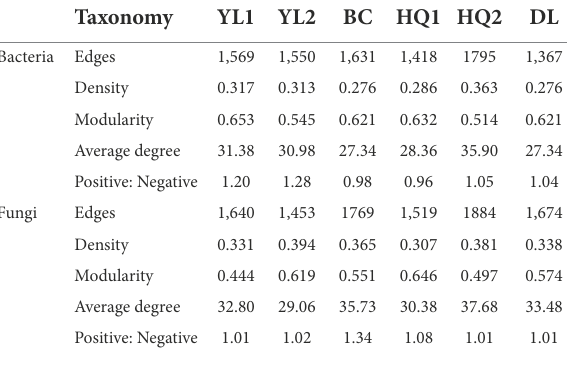
TABLE 4 Network topological properties of bacterial and fungal communities in different sample sites.